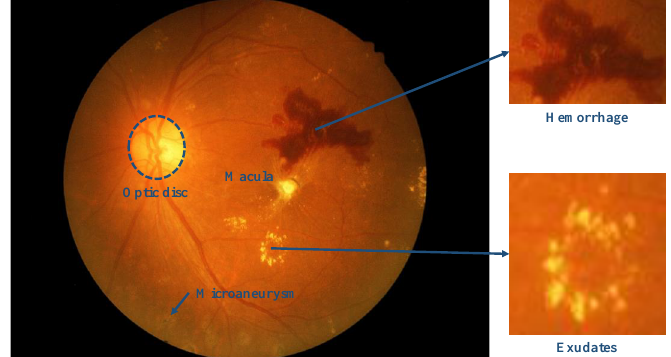
Figure 1. Early pathological signs of DR, such as soft/hard exudates, microaneurysms and hemorrhage. The picture is kindly provided by Messidor database [17], no conflict of